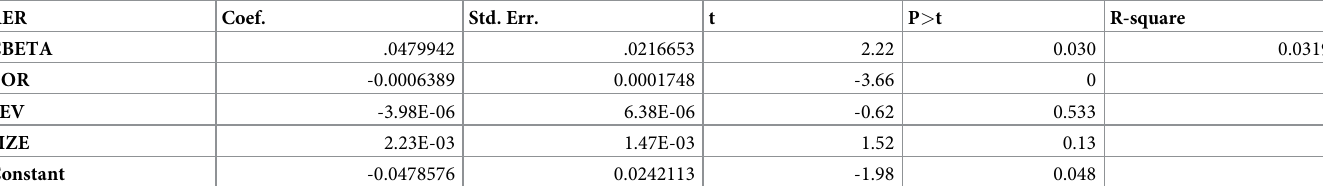
Table 4. Beta fixed effect results.